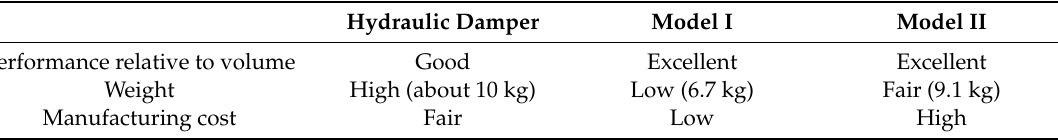
Table 3. Comparison between the specifications of traditional damper, Model I, and Model